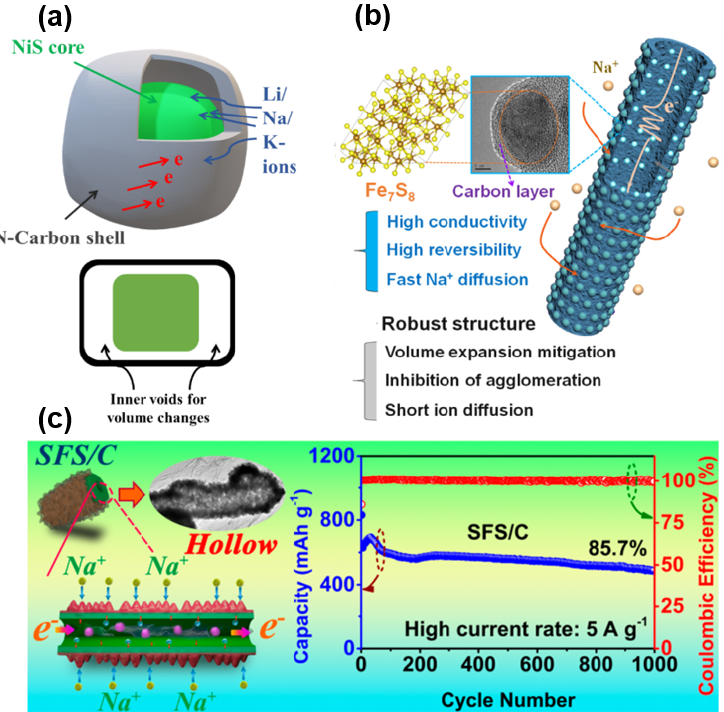
Figure 16. ( a ) Schematic diagram of the box-like core/shell NiS@Carbon that can transport and store Li/Na/K-ions [117]. ( b ) Schematic diagram of the NHCFs/Fe 7 S 8 and the advantages of this material [119]. ( c ) Schematic structure of SFS/C (Sb 2 S 3 @FeS 2/ N-doped graphene) on the left, and the cycling performance on the right [120].